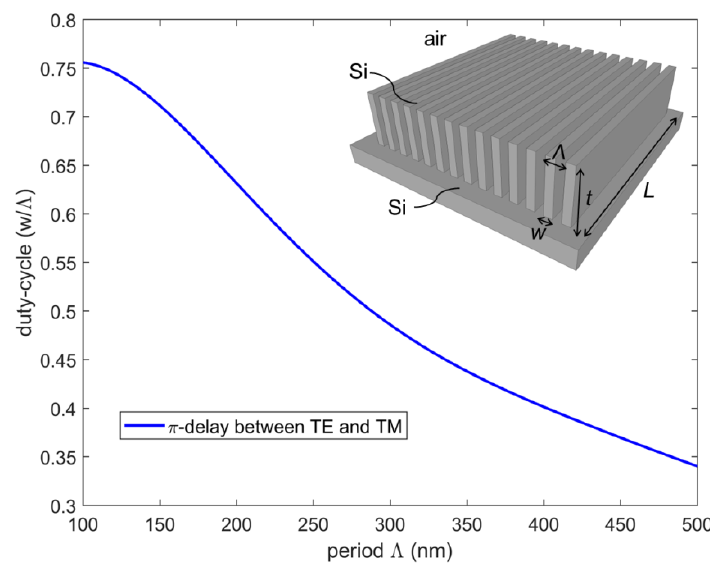
Figure 3. Configurations of duty cycle and period for a silicon subwavelength grating, providing a π -delay retardation between TE and TM polarizations, for a wavelength of 1310 nm at normal incidence. Numerical data obtained with rigorous coupled-wave analysis (RCWA) for a grating thickness of 535 nm.